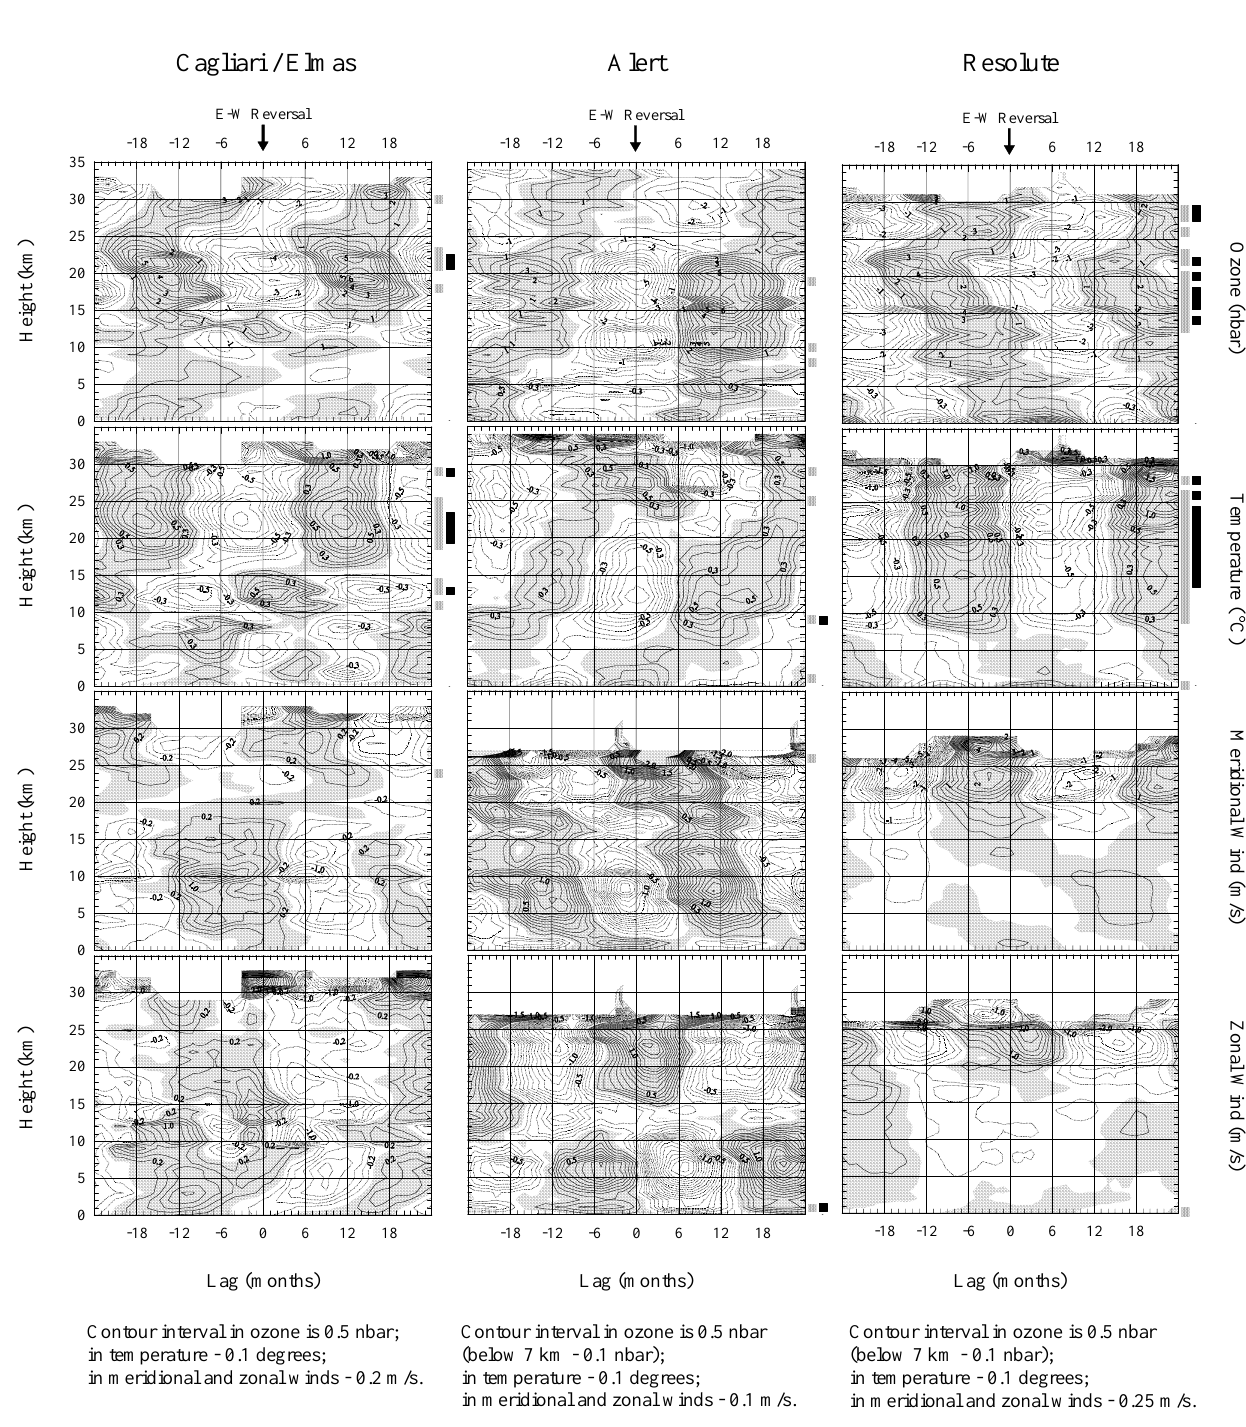
Contour interval in ozone is 0.5 nbar; in temperature - 0.1 degrees; in meridional and zonal winds - 0.2 m/s.